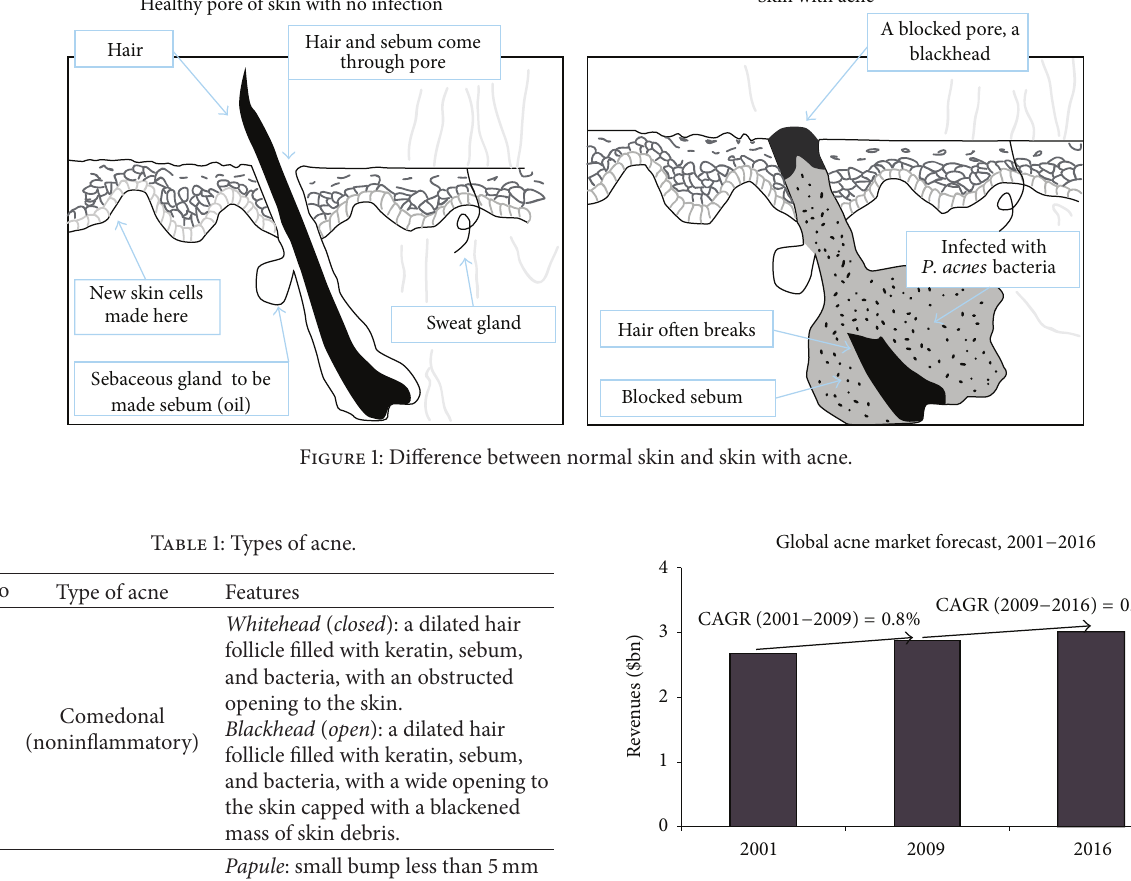
Figure 2: Future forecast of